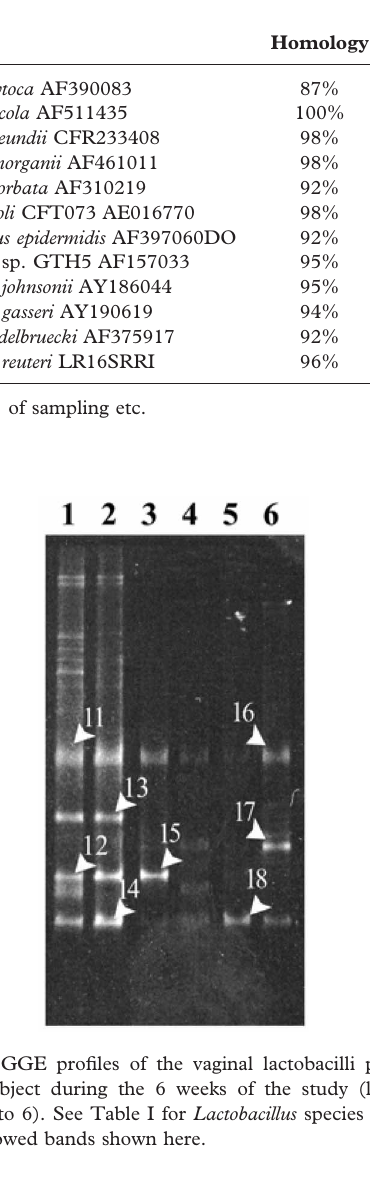
Species Homology